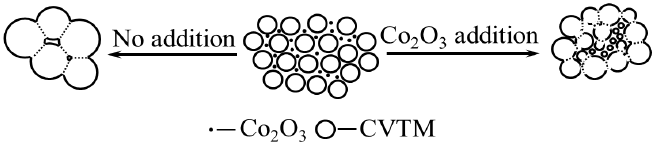
Figure 11. Schematic diagrams of oxidation induration mechanism of CVTP with Co 2 O 3 addition.